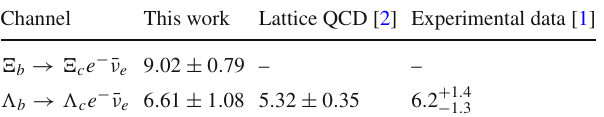
Table 6 Our predictions for the semi-leptonic branching fractions (in units of %) are compared with those from lattice QCD [2] and experi- mental data [1]